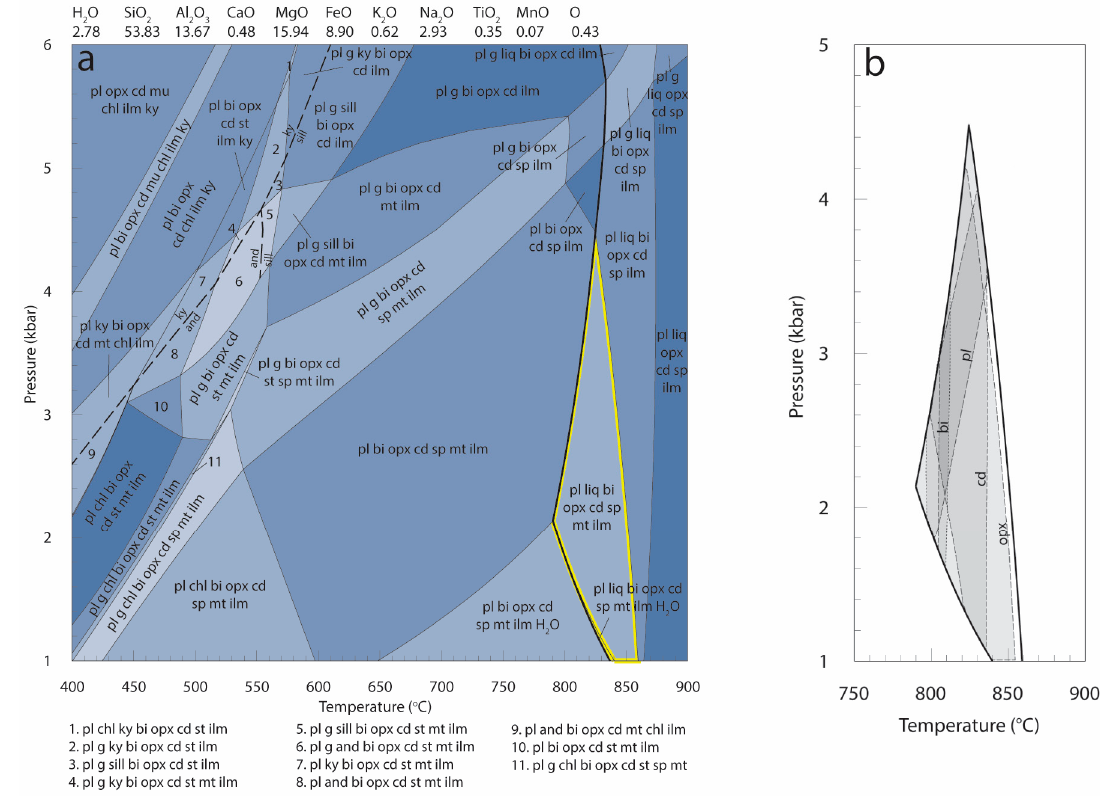
Figure 4. ( a ) Calculated P–T pseudosection using the composition of the residual orthopyroxene- bearing domain. The bulk composition (in mol%) is given above the pseudosection. The bold black line represents the solidus and the field outlined in yellow is the interpreted peak assemblage. ( b ) Overlay of modal contours on the peak field of Figure 4a. To avoid making the diagram overly complex, only the most abundant phases were included on the overlay. The contours of each mineral on the peak field of the P–T section represent the modal abundances of the major phases in sample 14-RDC-04, including plagioclase, biotite, orthopyroxene and cordierite. Primary overlap of phases occurs between 2–4 kbar in the peak field. Individual modal proportion plots for each mineral can be found in Appendix